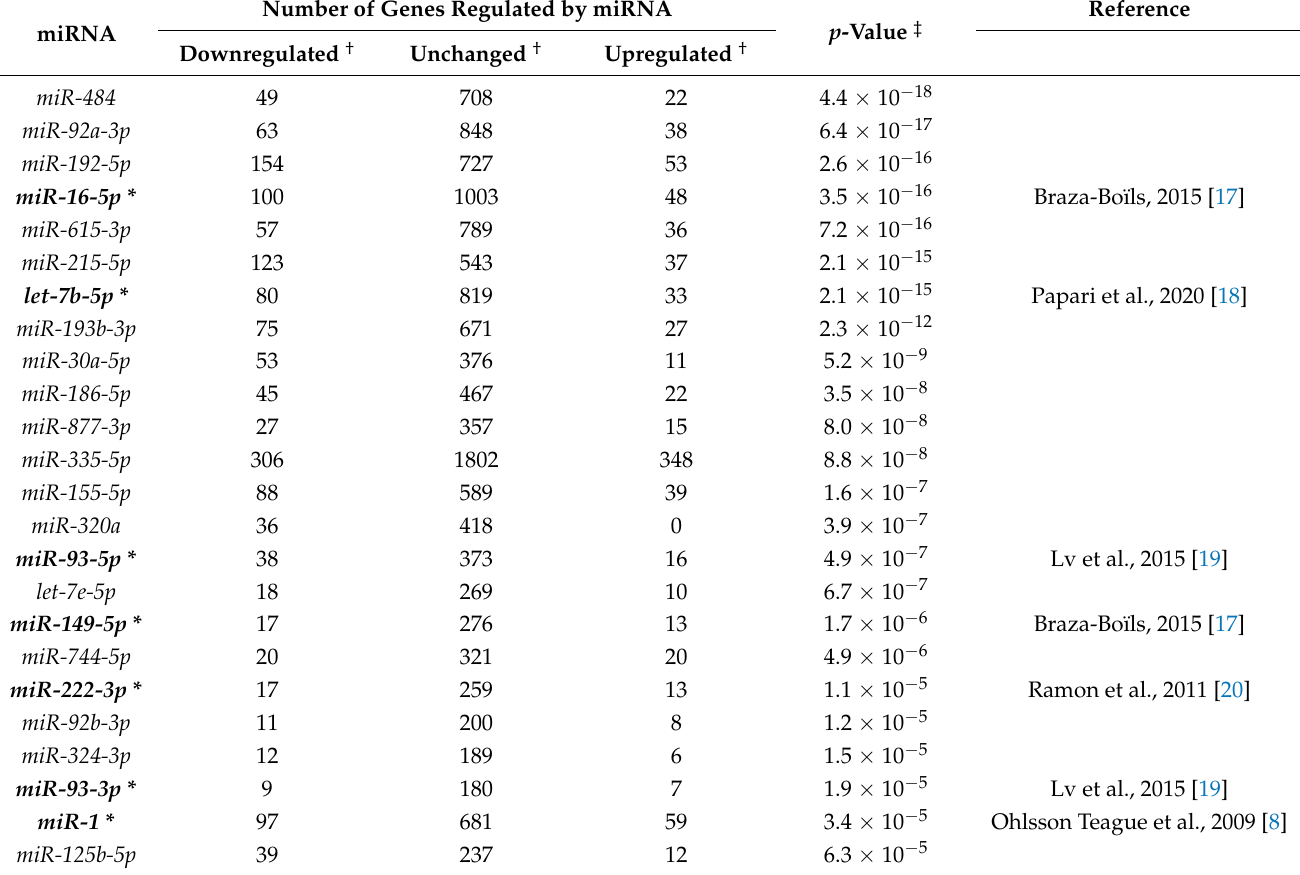
Table 4. List of putative miRNAs regulating genes differentially expressed in ovarian endometrioma, as predicted by bioinformatic